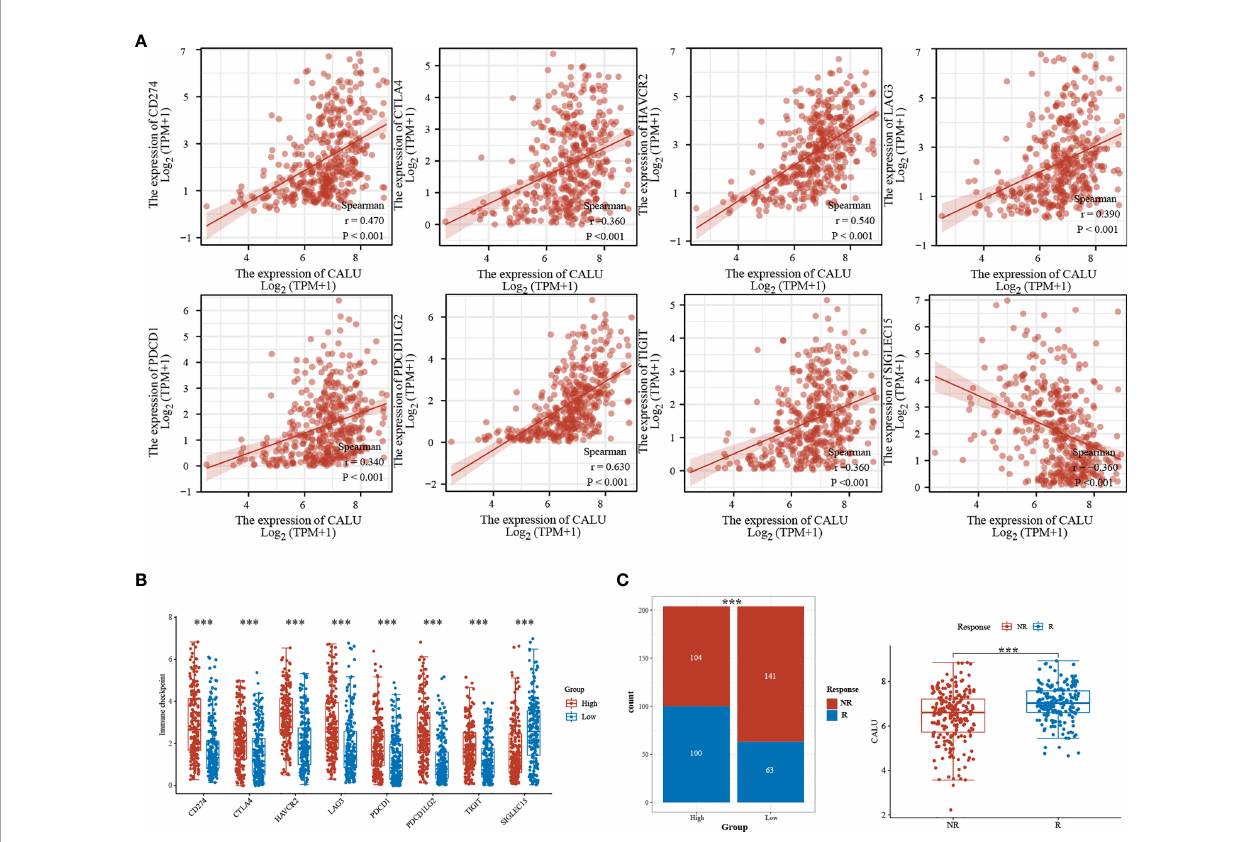
FIGURE 6 | Signi fi cant correlation of CALU with multiple ICRGs. (A, B) CALU was positively correlated with CD274 (p<0.001, R=0.470), CTLA4 (p<0.001, R=0.360), HAVCR2 (p<0.001, R=0.540), LAG3 (p<0.001, R=0.390), PDCD1 (p<0.001, R=0.340), PDCD1LG2 (p<0.001, R=0.630), and TIGIT (p<0.001, R=0.360), while negatively correlated with SIGLEC15 (p<0.001, R=-0.360). (C) ICB therapy responsiveness predicted by Immunecell AI indicated a signi fi cantly higher response rate in CALU high patients than in CALU low patients(p<0.001). The CALU expression level in ICB responders was higher than that in non-responders (p<0.001).